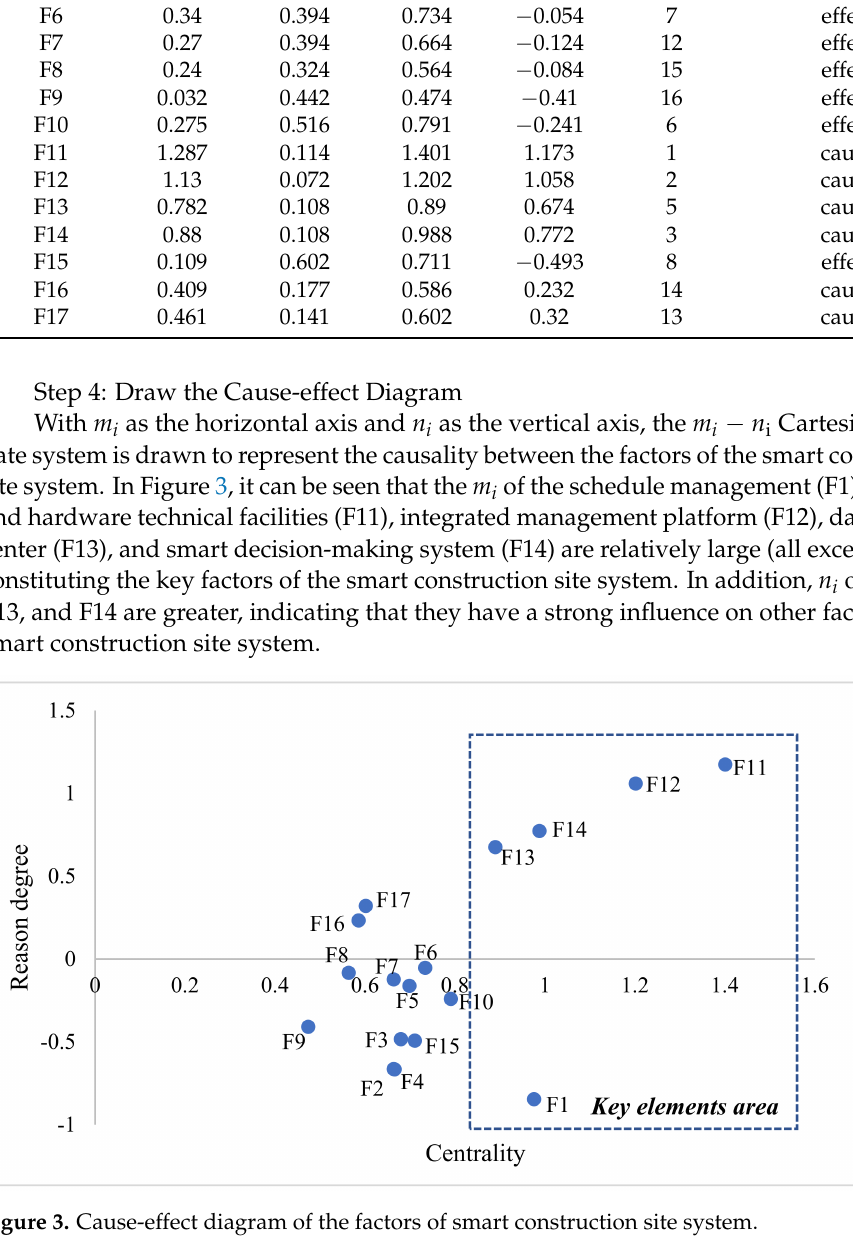
Figure 3. Cause-effect diagram of the factors of smart construction site